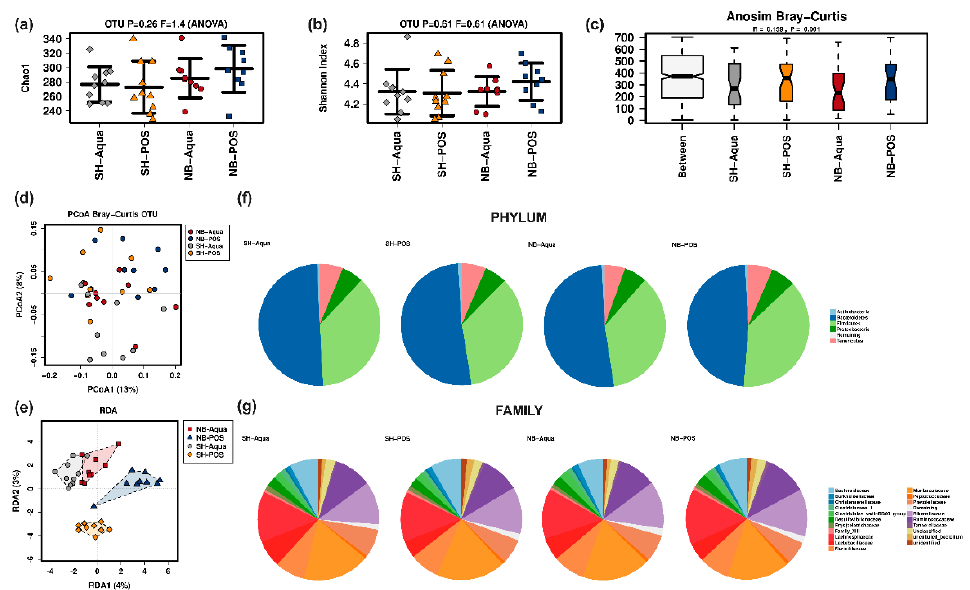
Figure 3. ( a ) Chao1 and ( b ) Shannon index; ( c ) Anosim Bray–Curtis, ( d ) PCoA Bray–Curtis, ( e ) redundancy analysis (RDA) and relative abundances at the ( f ) phylum and ( g ) family level. NB—neuroblastoma; SH—sham; POS—prebiotic oligosaccharide.